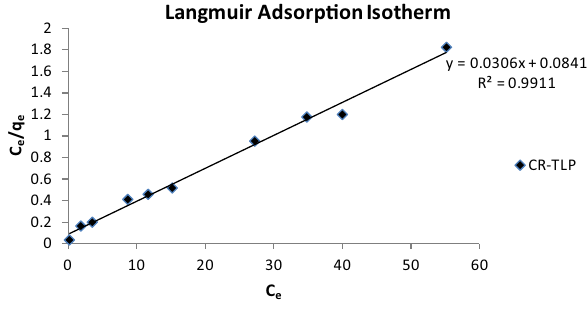
Fig. 15 Langmuir adsorption isotherm model. Temperature—30 °C, concentration—20 ppm, adsorbent dose—150 mg, pH—6, vol- ume—100 ml